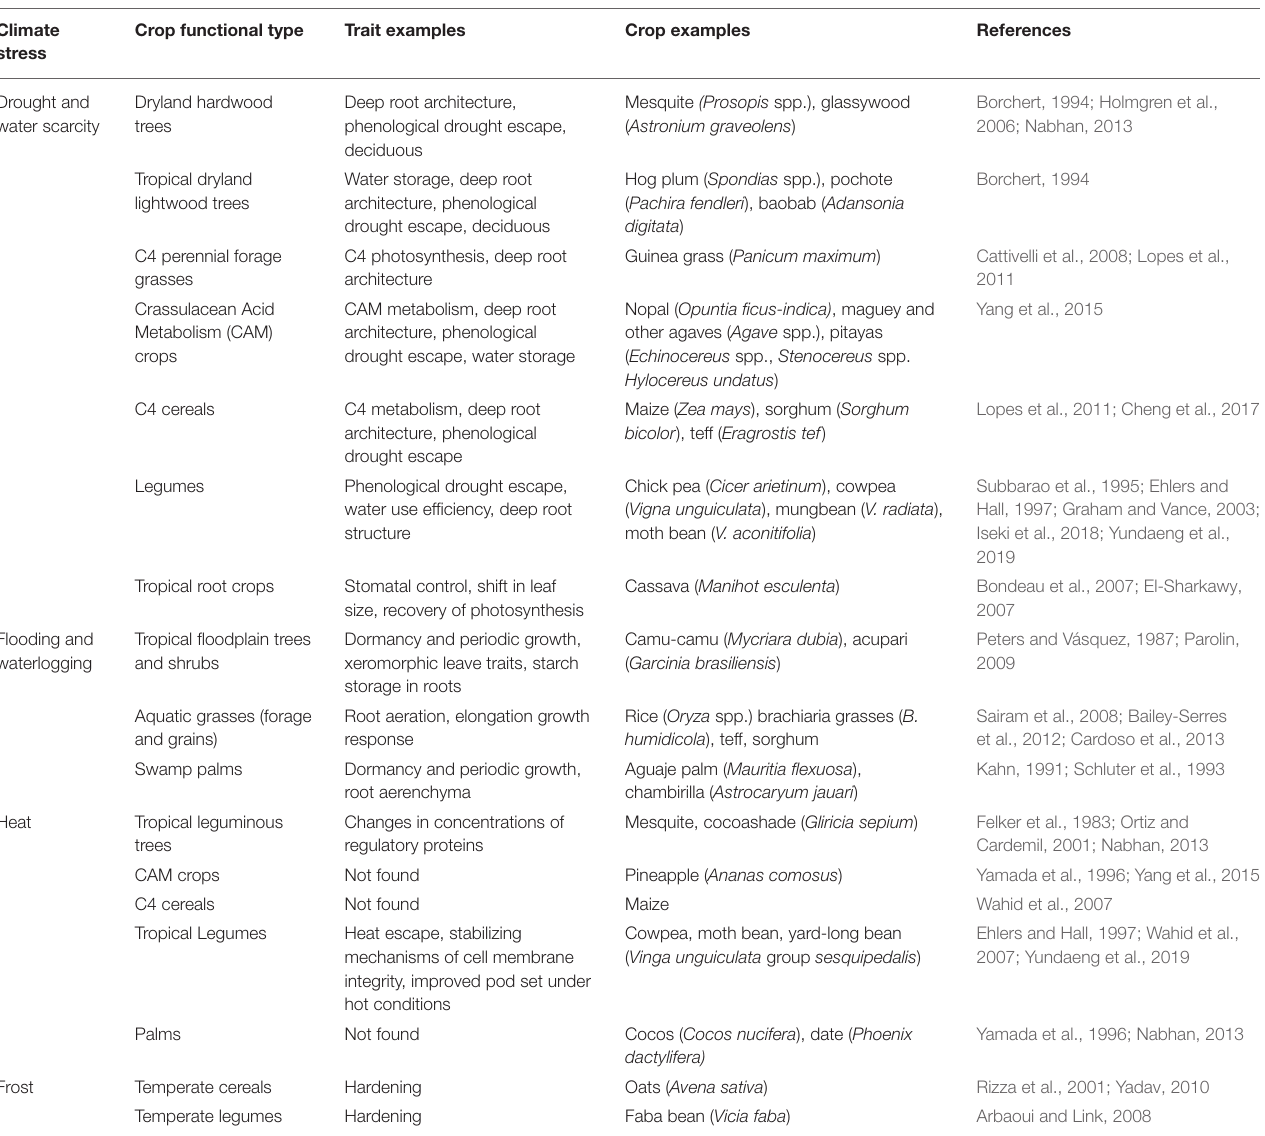
TABLE 2 | Crop functional types and crop examples to diversify in response to various climate stresses. Climate